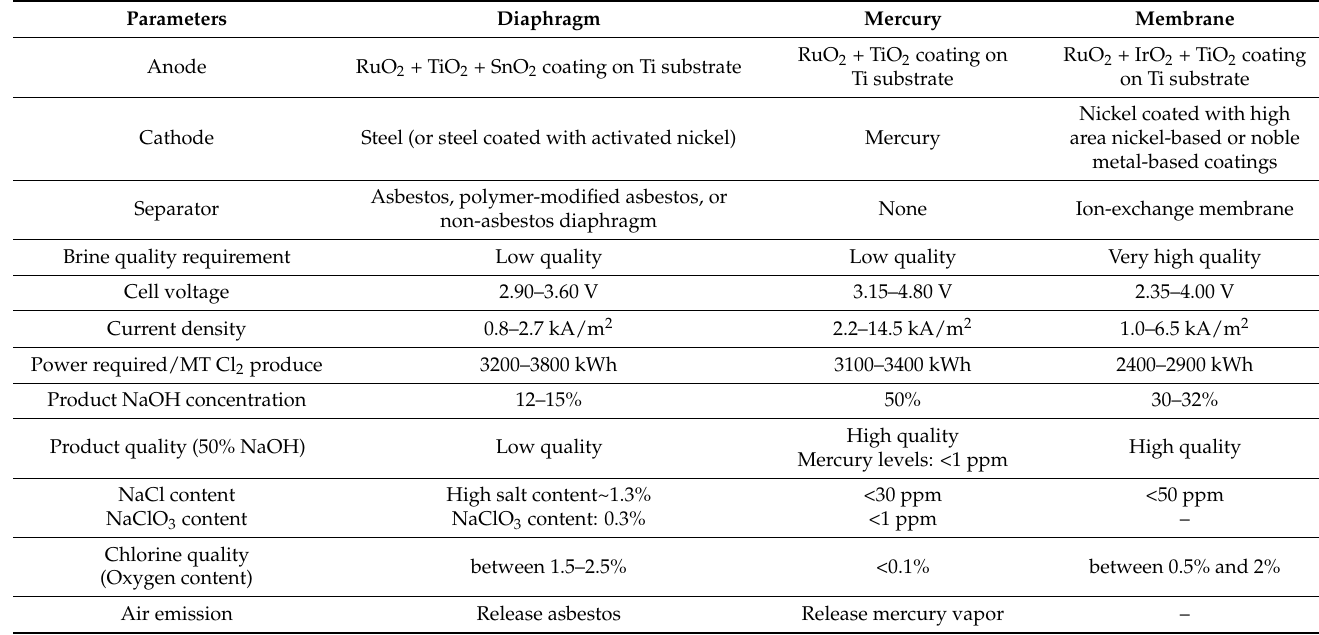
Table 1. Comparative analysis of Diaphragm, Mercury and Membrane cell process